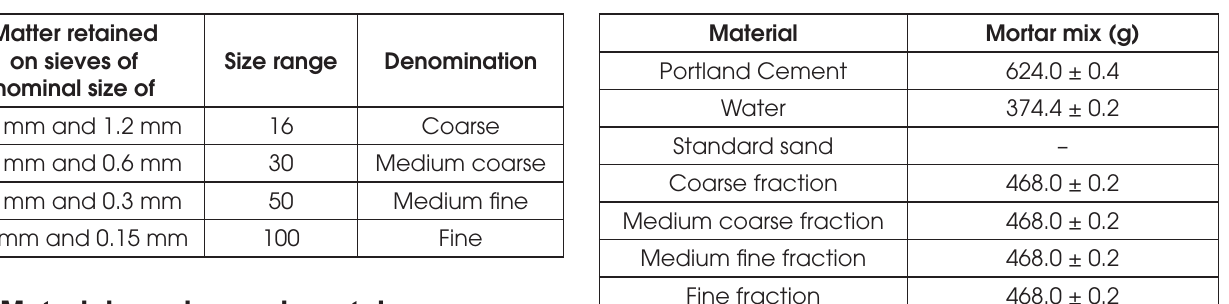
E. LACERDA | A.G. MAGALHÃES | E. E. BERNARDES | E. H. M. NUNES | W. L. VASCONCELOS